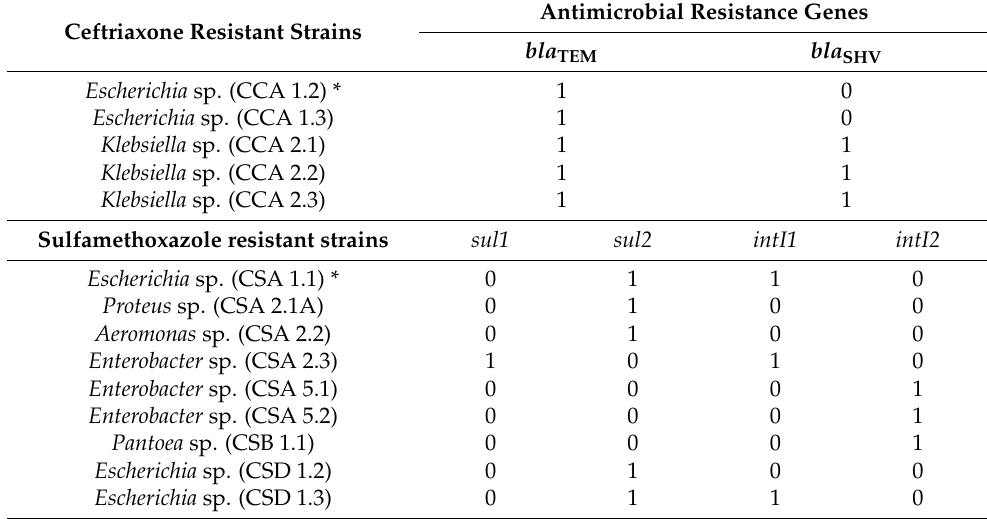
Table 1. Presence of antimicrobial resistance genes in the isolated strains. Ceftriaxone Resistant